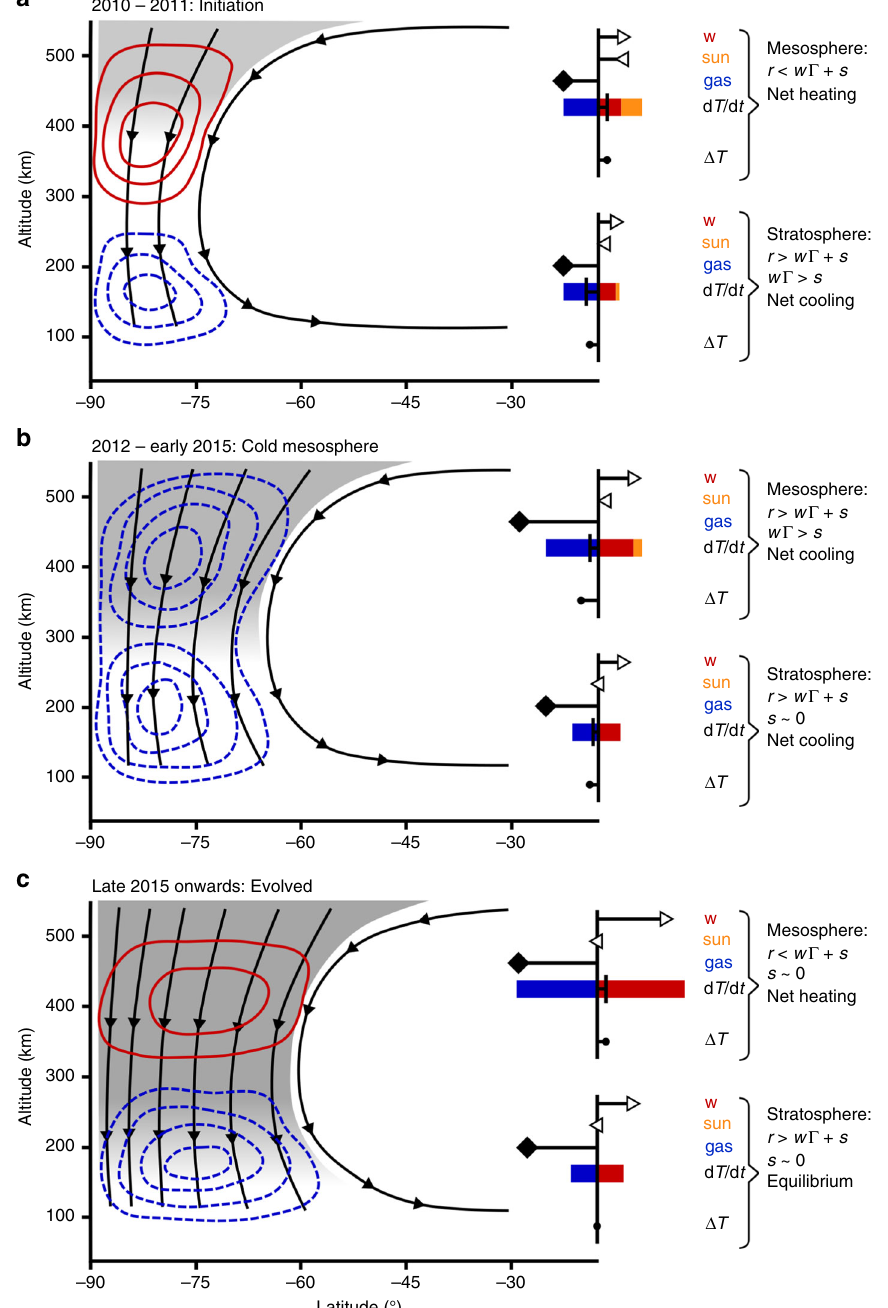
Fig. 8 Schematic of the three stages of Titan ’ s vortex evolution. Shaded areas represent trace gas abundance, which increases with time due to the subsiding fl ow (black streamlines). Red contours indicate hot anomalies and blue-dashed contours represent cold anomalies. Inset bar plots in each panel represent mesospheric and stratospheric heating and cooling processes; right-pointing triangles indicate subsidence speed w , which drives adiabatic heating rate w Γ (red bar); left-pointing triangles indicate solar heating rate s (orange bar); and diamonds indicate trace gas relative abundance, which drives long-wave radiative cooling rate r (blue bar). The overall net heating rate ∂ T / ∂ t = − r + w Γ + s (vertical line) produces either a hot or cold temperature anomaly Δ T ( fi lled circle). Estimated long-wave cooling rates are given in Table 1 and range from 0.75 to 3.3 K per day in the mesosphere (~0.01 mbar, 400 km) and 0.04 – 0.17 K per day in the stratosphere (~1 mbar, 175 km). The three stages are: a vortex initiation, with a hot mesosphere driven by modest subsidence-induced adiabatic heating combined with weak cooling from trace gases; b cold mesosphere, caused by enhanced net cooling from increased trace gas opacity; and c evolved vortex, with a hot mesosphere driven by strong subsidence-induced adiabatic heating that exceeds enhanced cooling